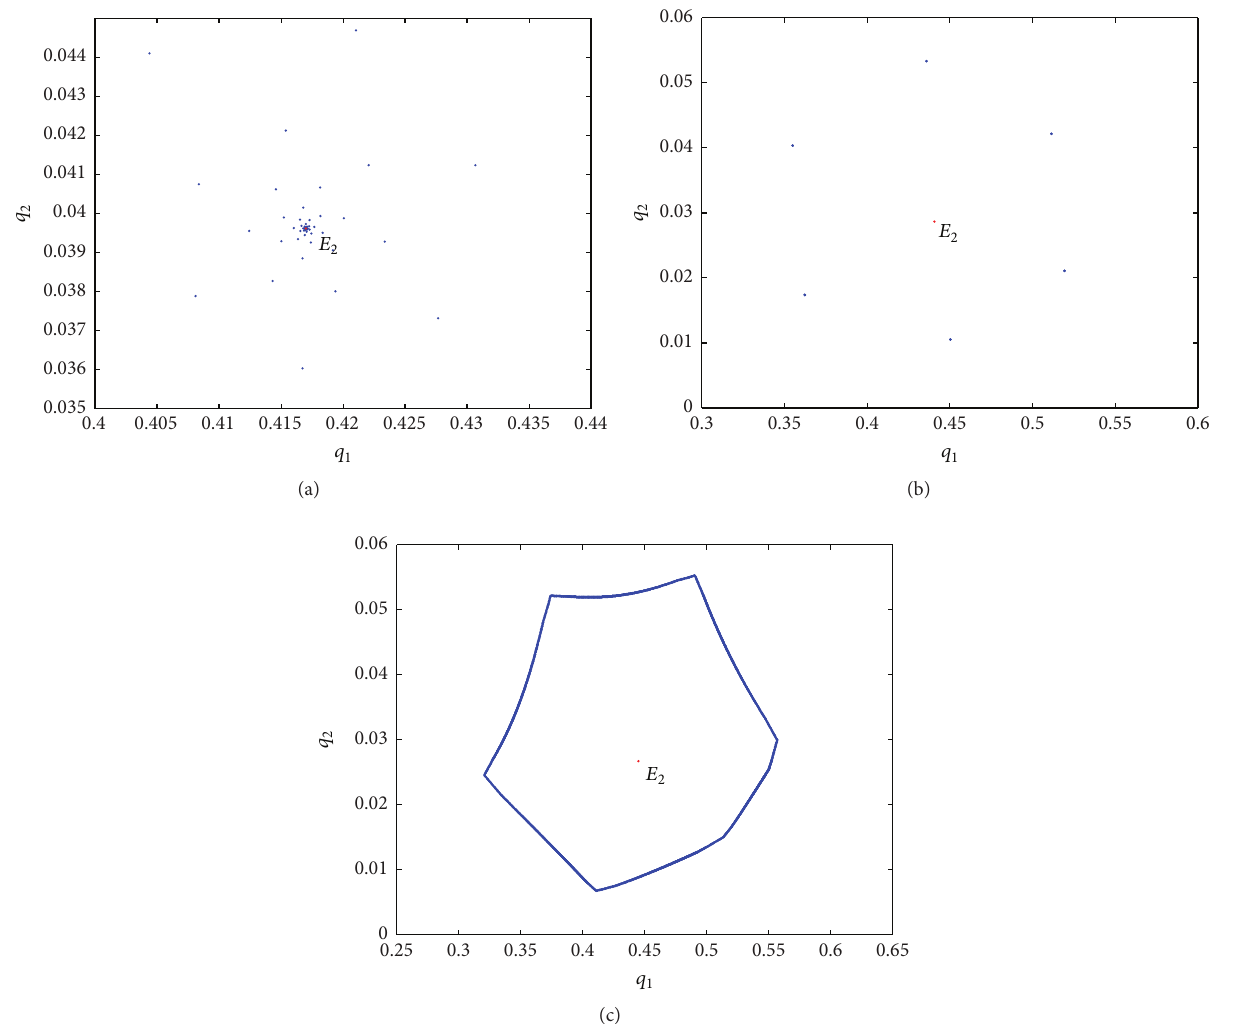
Figure 3: (a) Phase portrait of map (8) for V 1 = 0.5, V 2 = 0.5, 𝑐 1 = 0.19, 𝑐 2 = 2 . (b) Phase portrait of map (8) for V 1 = 0.5 , V 2 = 0.5, 𝑐 1 = = 2 . (c) Phase portrait of map (8) for V 0.13, 𝑐 2